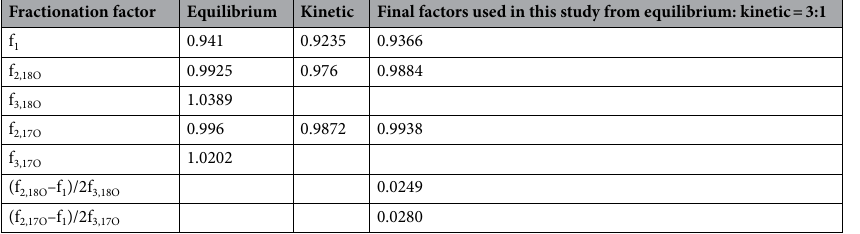
Table 2. Isotope fractionation factors measured in vitro for the equilibrium and kinetic exchanges of 2 H, 18 O and 17 O between liquid water and vapor, and for the 18 O, 17 O between water and gaseous CO 2 at 37 °C 4,15,17–19,25 .